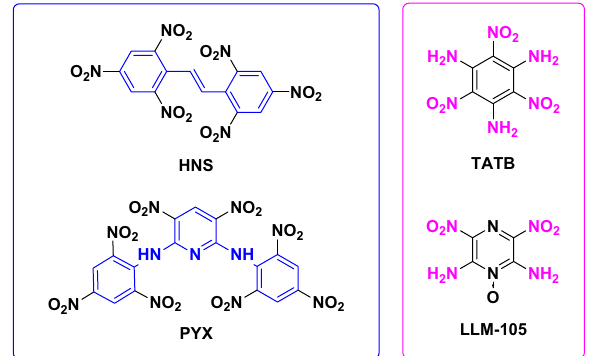
Figure 1. Representative heat-resistant energetic materials.